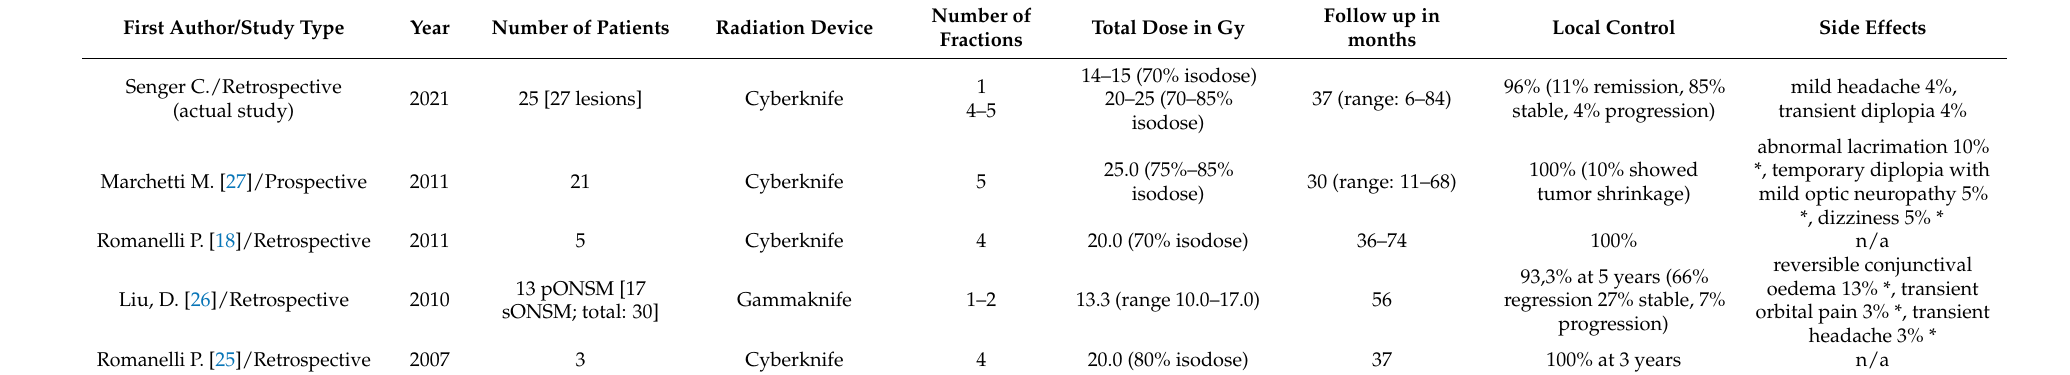
Table 4. Overview of all published radiosurgery studies of ONSM concerning local control and side